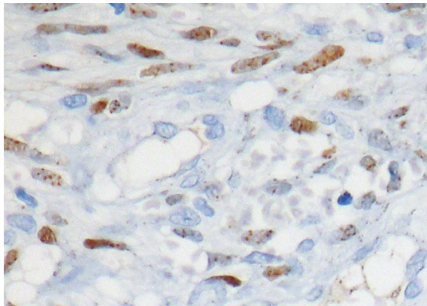
Figure 6: Apparent nuclear HHV-8 positivity in tumor cells (orig- inal magnification, H&E ×